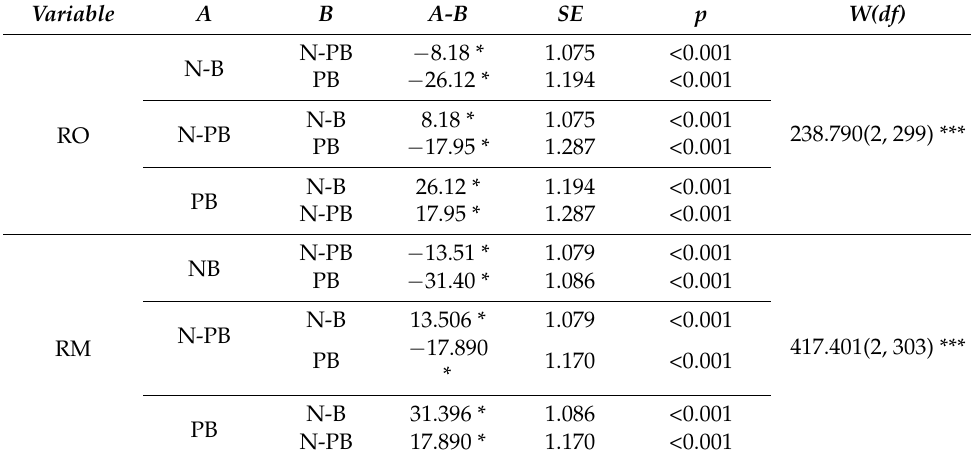
Table 4. Results of the one-way ANOVA and Tamhane’s T2